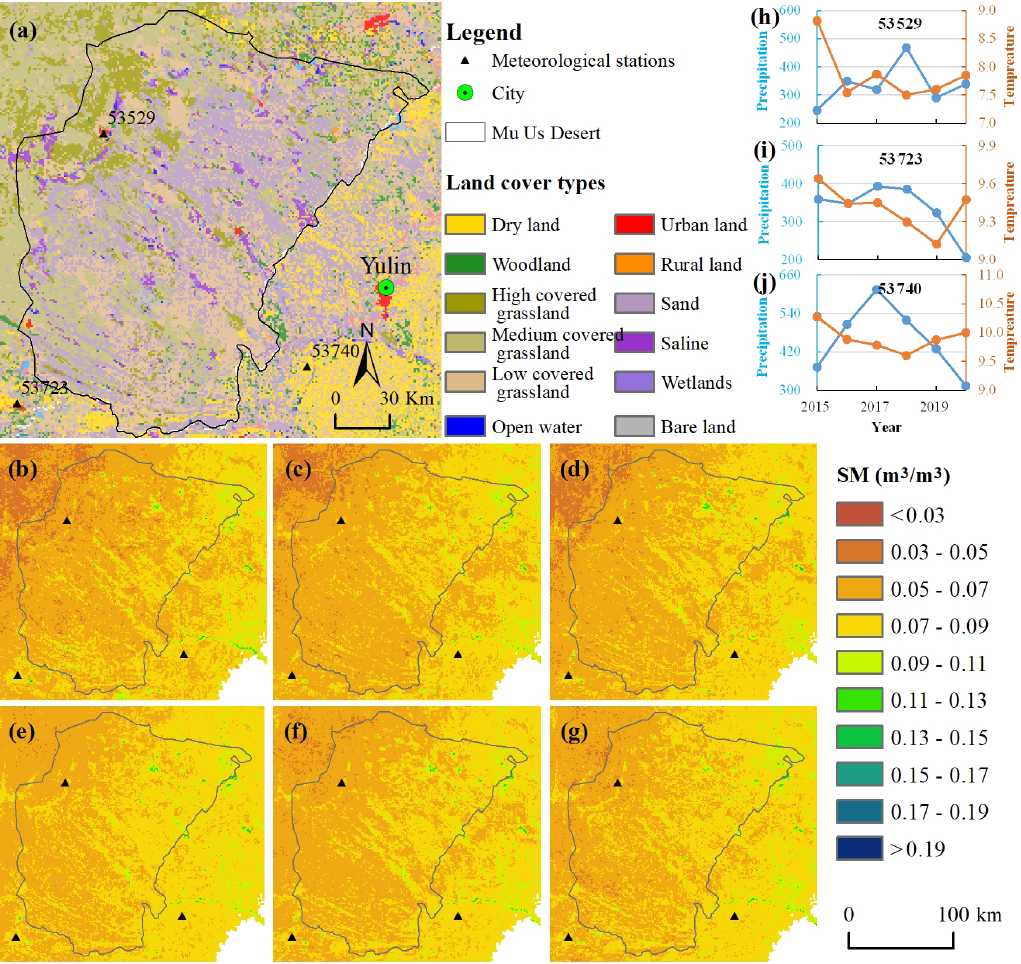
Figure 12. Soil moisture estimated for the Mu Us Desert. (a) Land cover distribution over the study area; (b–g) annual average SM from 2015–2020; (h–j) annual precipitation and annual average temperature of three sites (53529, 53723 and 53740), whose surroundings are mainly grassland, cultivated land and cultivated land,